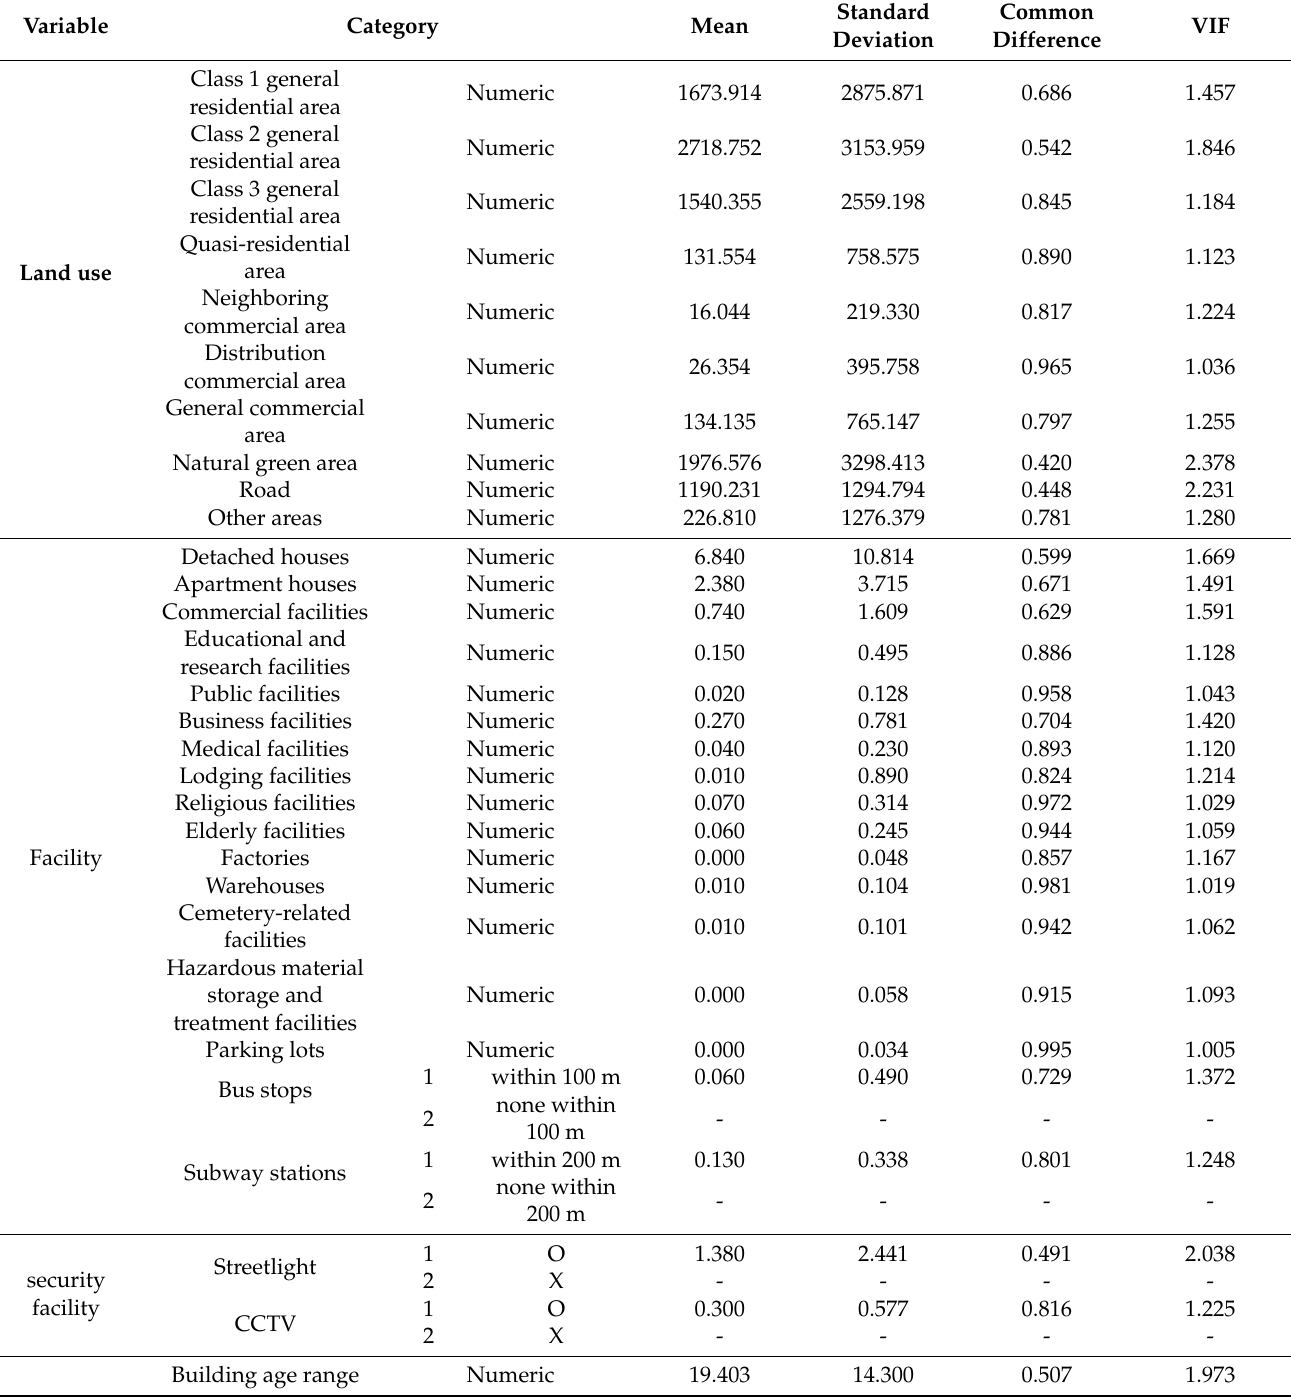
Table 2. Data construction, descriptive statistics, and Variance Inflation Factor (VIF) analysis results.